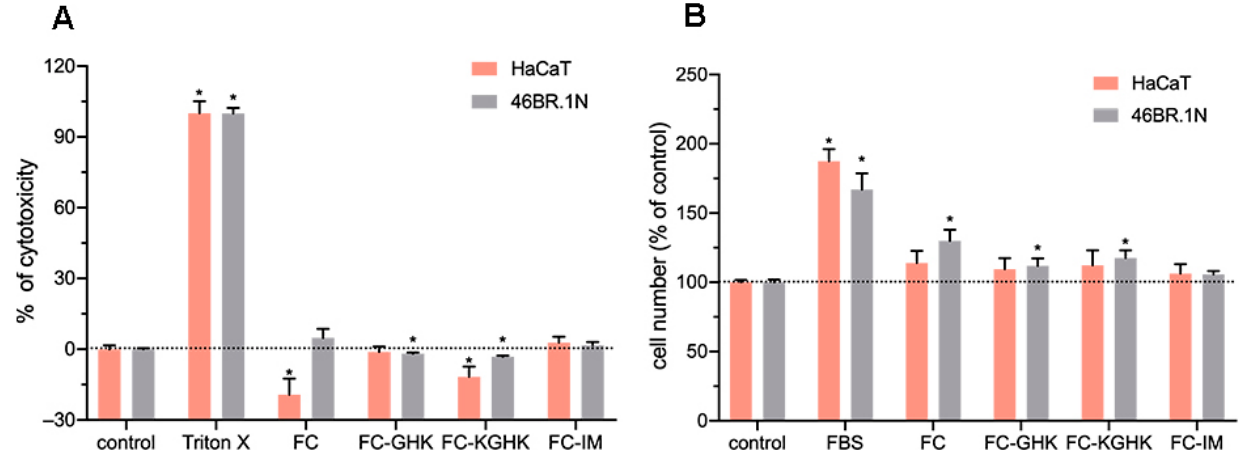
Figure 12. Effect of fibrils on human skin cells after 48 h of incubation. ( A ) Cytotoxicity of the scaffolds toward HaCaT keratinocytes and 46BR.1N fibroblasts; ( B ) Scaffold effect on proliferation of HaCaT keratinocytes and 46BR.1N fibroblasts. The graphs show results from three independent experiments. Results are presented as mean with SEM. *- statistically significant differences compared to control, Mann-Whitney U test, p <